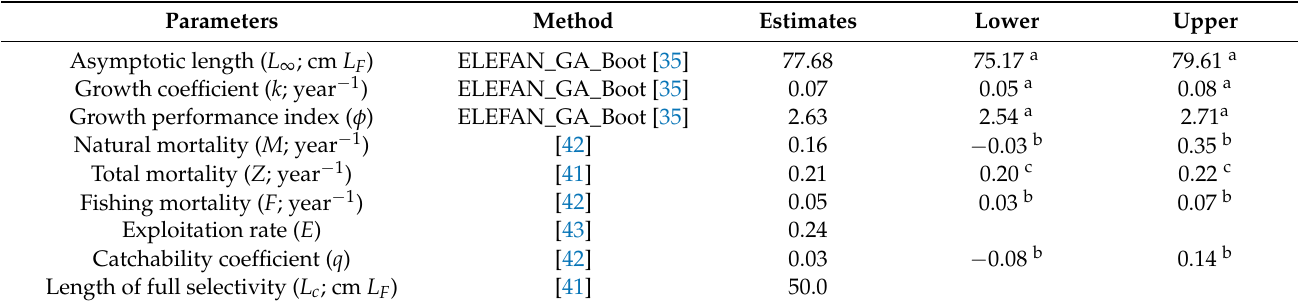
Table 2. Growth and fishery parameters for Mora moro in the Azores estimated from L F –frequency data for the period 2010–2016. Data from the EU Data Collection Framework (DCF). Lower and upper denote ( a ) 95% confidence interval, ( b ) standard deviation, or ( c ) standard error limits of the estimates.